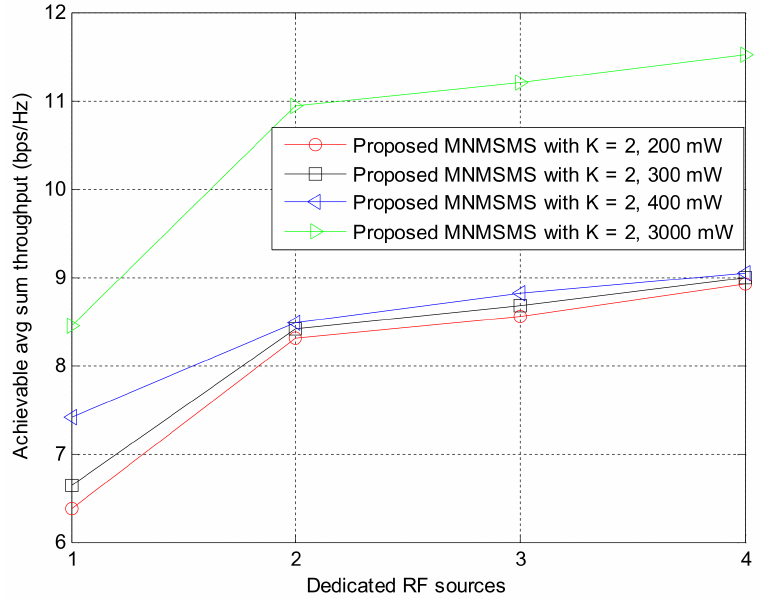
Figure 10. The impact of transmit power on the system-achievable throughput